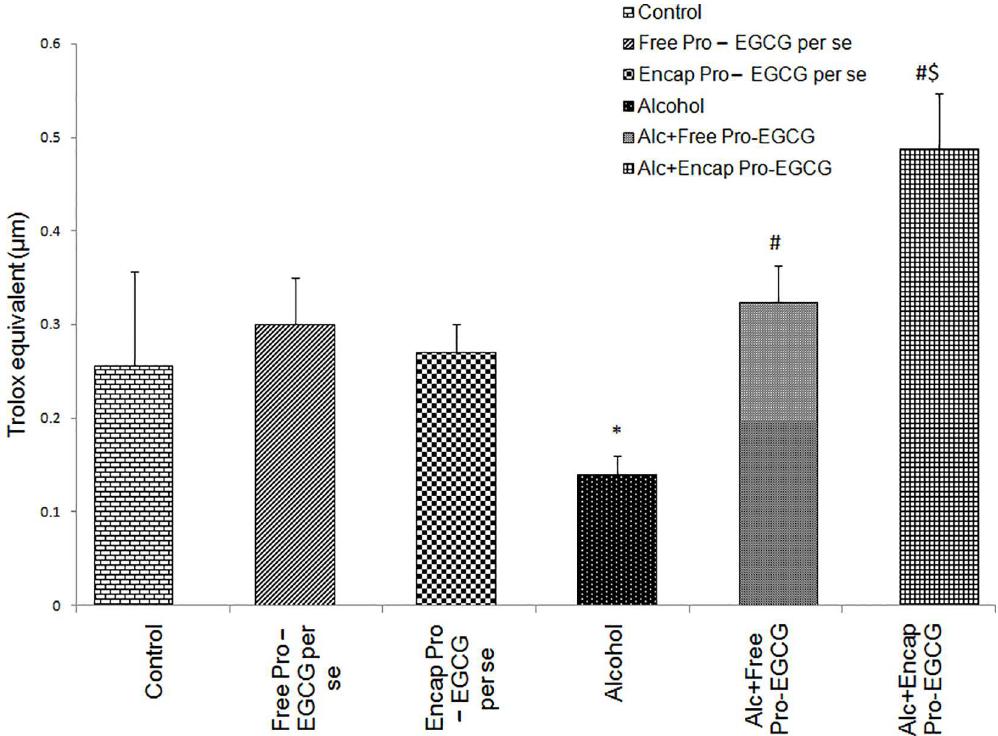
Fig 5. Effect of probiotic- EGCG combination (free and encapsulated) on PAO levels, * p < 0.05vs. control, # p < 0.05 vs. alcohol group, $p < 0.05 vs. alcohol + free probiotic-EGCG group.